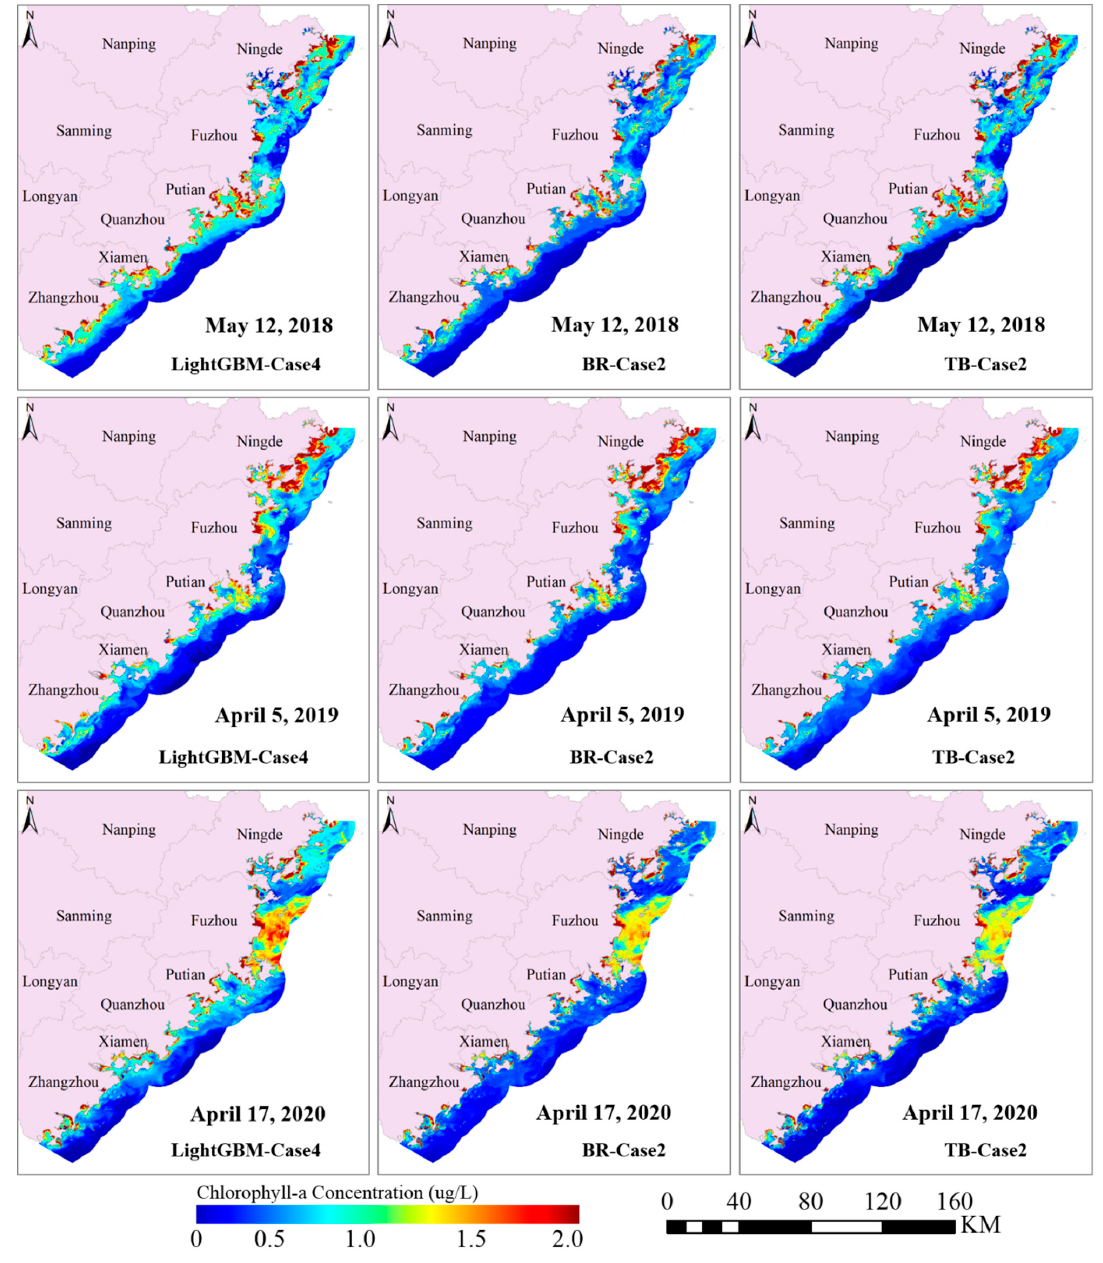
Figure 9. Spatial distribution of chl-a concentration based on the LightGBM-Case 4, BR-Case 2, and TB-Case 2 using the OLCI images on 12 May 2018, 5 April 2019, and 17 April 2020, in Fujian’s coastal waters.